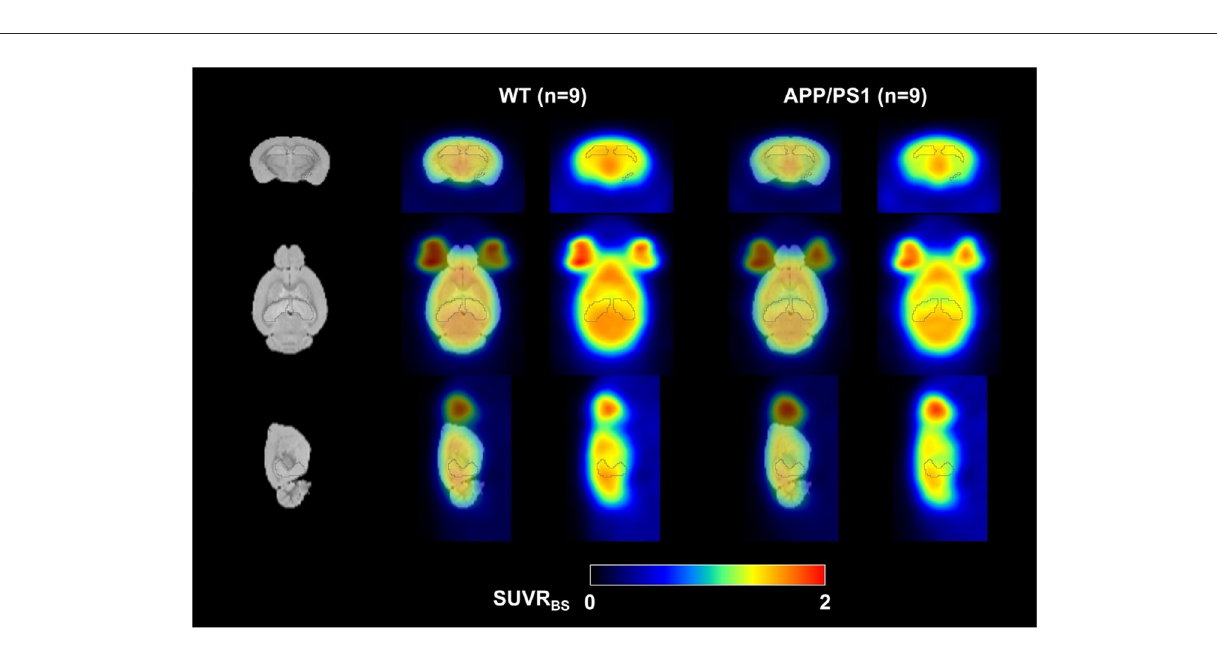
FIGURE4 Averaged [ 18 F]SDM-16 SUVR images for WT ( n = 9) and APP/PS1 ( n = 9) mouse brains. Color scale represents SUVR, averaged from 60 to 90min p.i. and normalized to brain